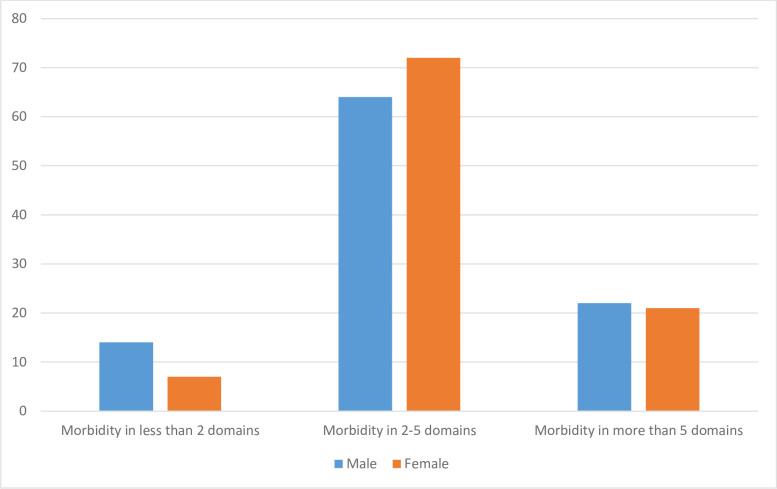
Distribution of multi-morbidity among indigenous older adults across gender.